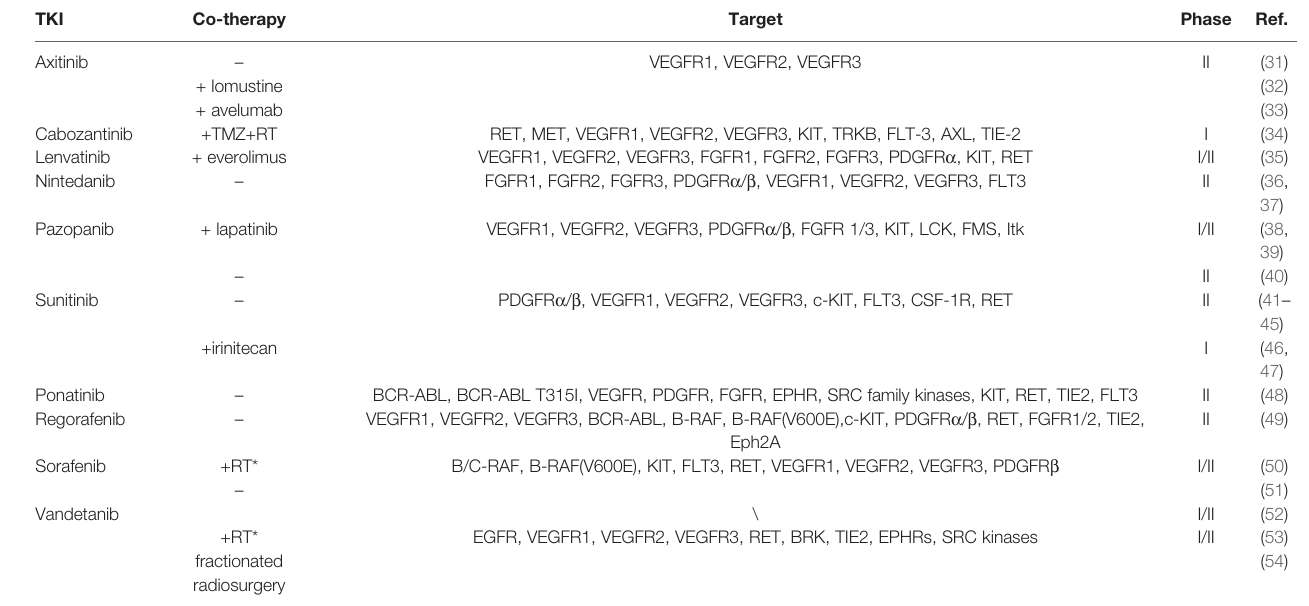
TABLE 3 | Clinical trials on TKRs for GBM.